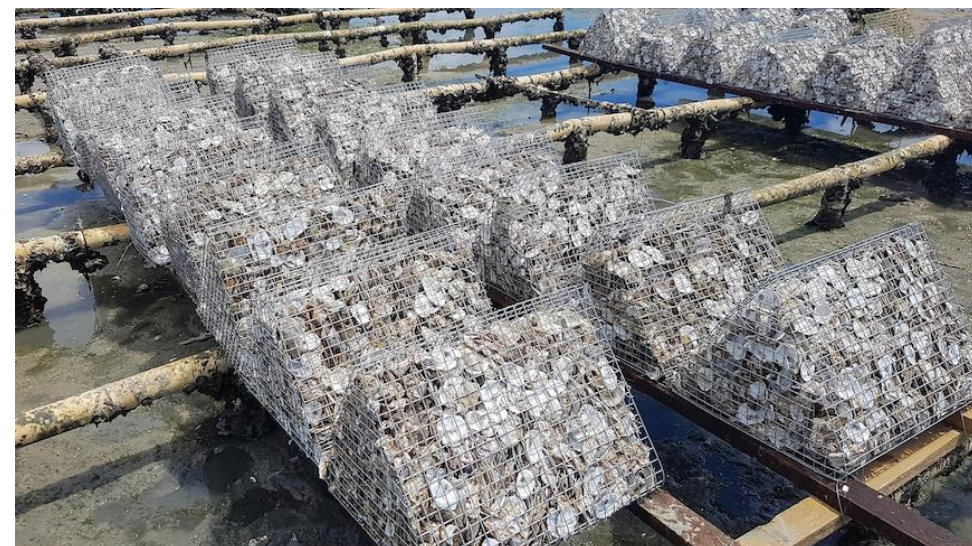
Figure 4. Discarded oyster shells from restaurants, usually destined for landfill, are being recycled to create shellfish reefs, in scope of the biggest community-driven reef restoration in Australia. ABC News (https://www.abc.net.au/news/2021-10-16/oyster-shell-waste-artificial-reef/100538272).